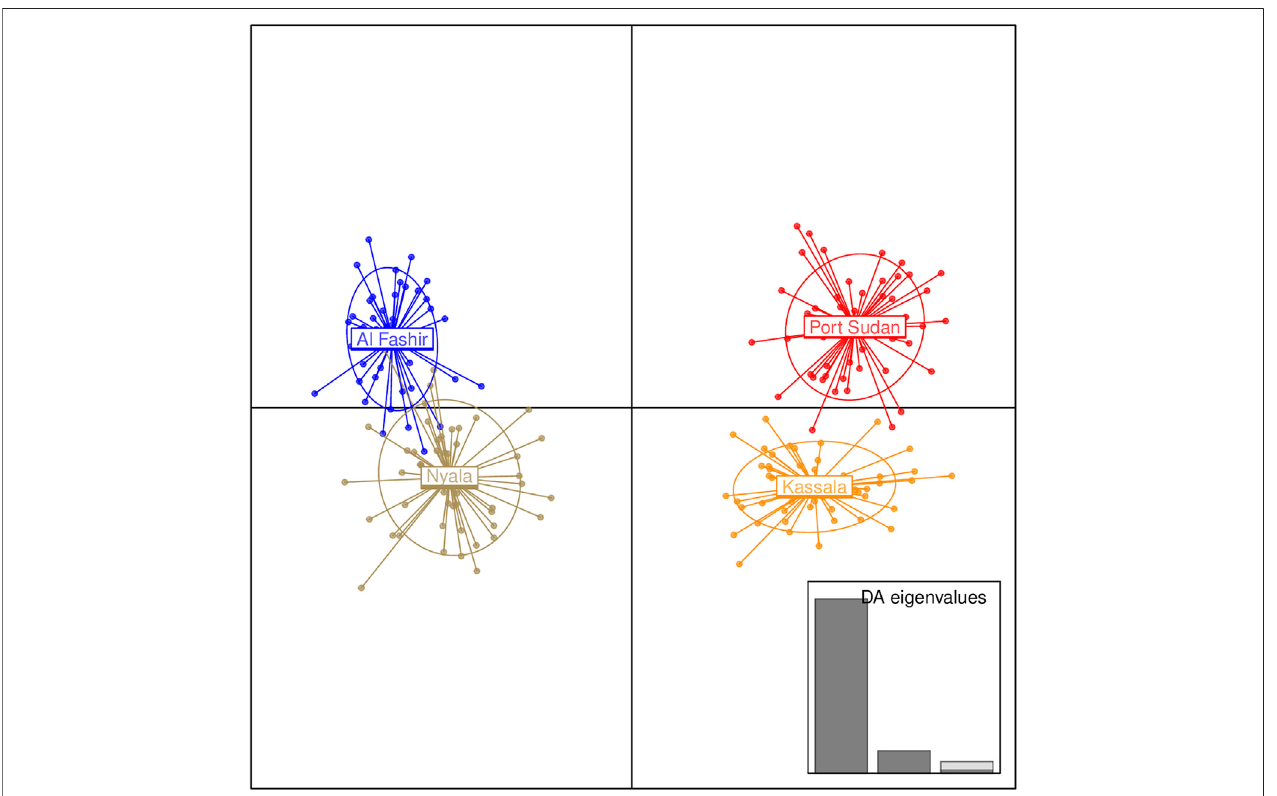
FIGURE 4 | Discriminant Analysis of Principal Components (DAPC) for the Ae. aegypti populations from Sudan based on the microsatellite dataset. The graph represents the individuals as dots and the groups as inertia ellipses. A bar plot of eigenvalues for the discriminant analysis (DA eigenvalues) is displayed in the inset. The number of bars represent the number of discriminant functions retained in the analysis and the eigenvalues correspond to the ratio of the variance between groups over the variance within groups for each discriminant function.